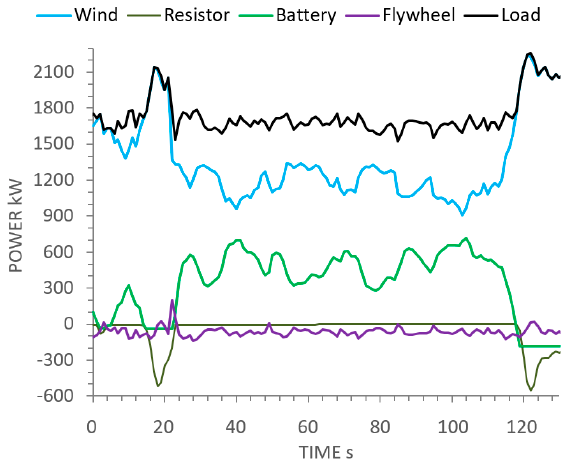
Figure4. King Island flywheel (purple) response to rapidloss of wind generation (light blue), supporting battery response (light green) and ride